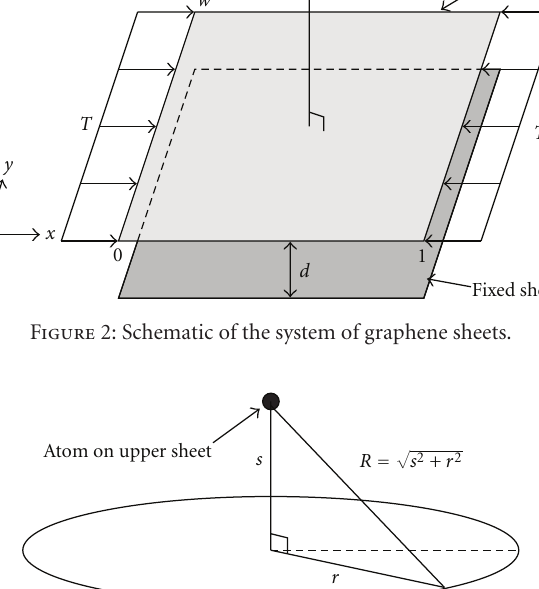
r Circular segment of lower (fixed) sheet Figure 3: Schematic of a single carbon atom which is distance s from an infinite graphene